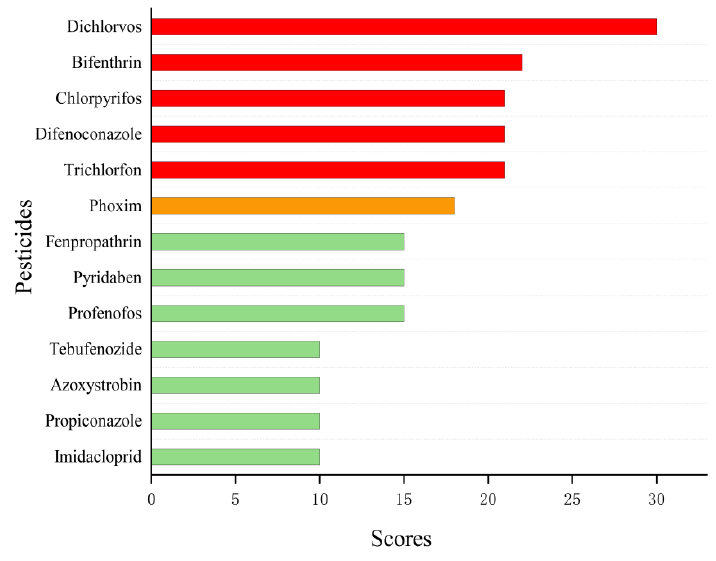
Figure 4. The risk ranking of residues of 13 pesticides in coix seeds.